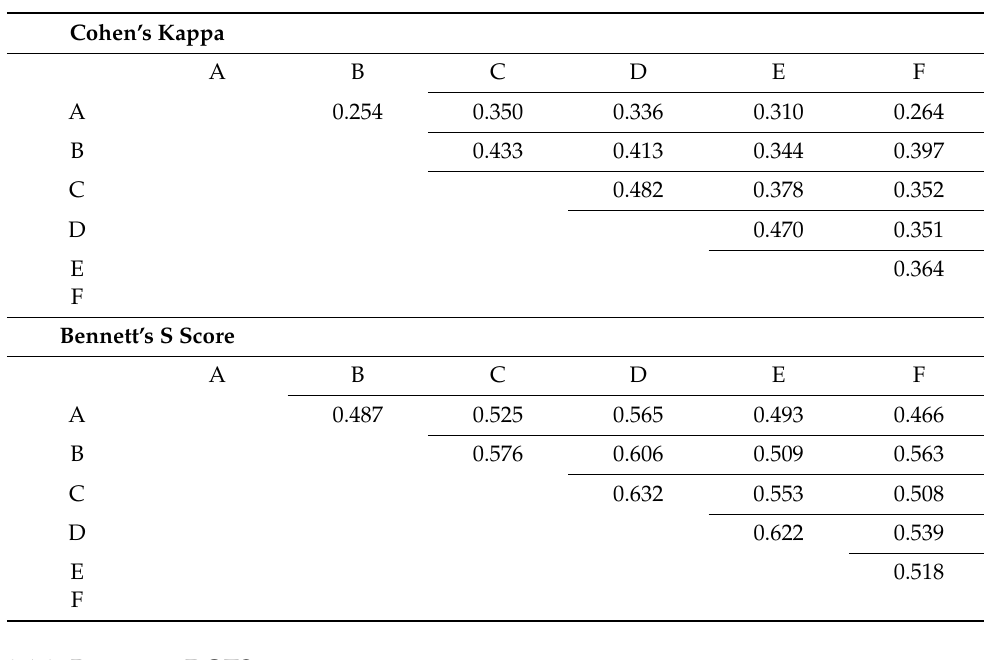
Table 2. Inter-Rater Reliability of Human Raters.